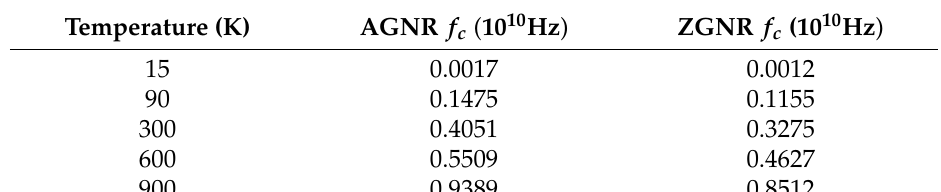
Table 6. Cut-off frequency vs temperature in the y-direction.